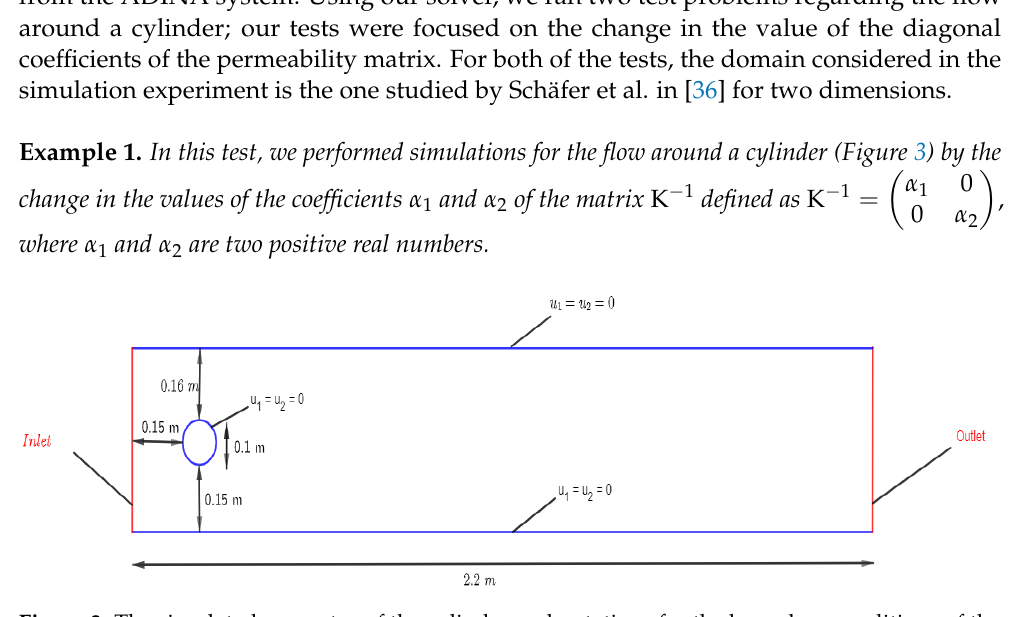
Figure 3. The simulated geometry of the cylinder and notations for the boundary conditions of the 2D test case.